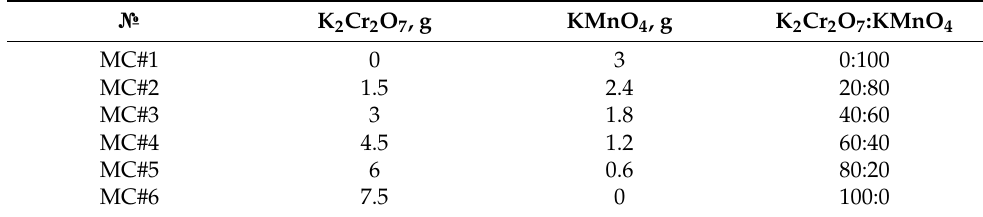
Table 1. Composition of oxidizing agents used in the synthesis of the GO